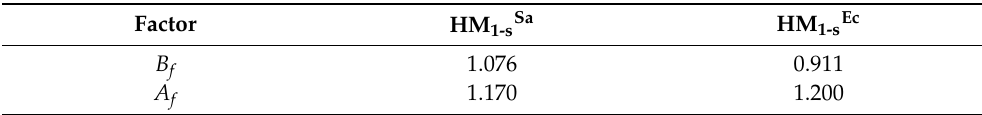
Table 6. Bias and accuracy of independent data sets of S. aureus (Sa), E. coli (Ec) during their growth as single cultures in